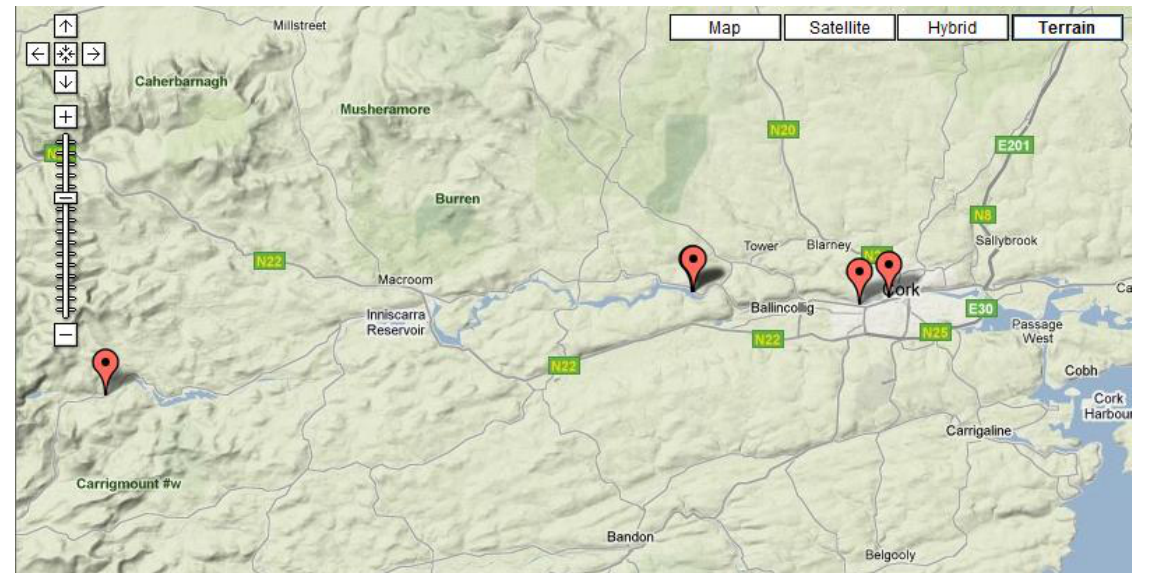
Figure 2. DEPLOY sites on the river Lee. Source: Google Maps and